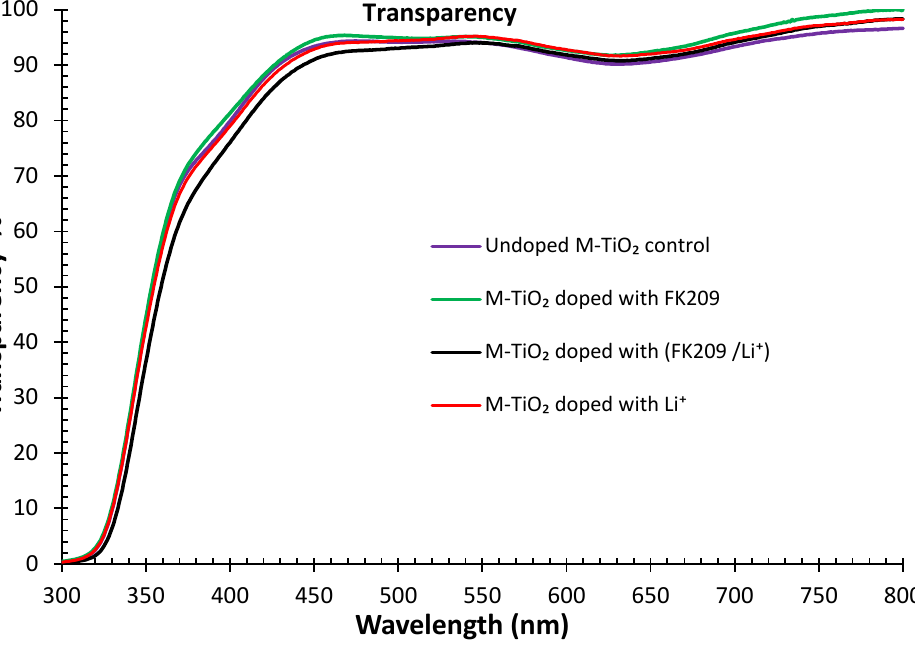
Figure 3. Optical transparency properties of mesoporous TiO 2 doped with FK209, FK209 /Li + , and Li + .